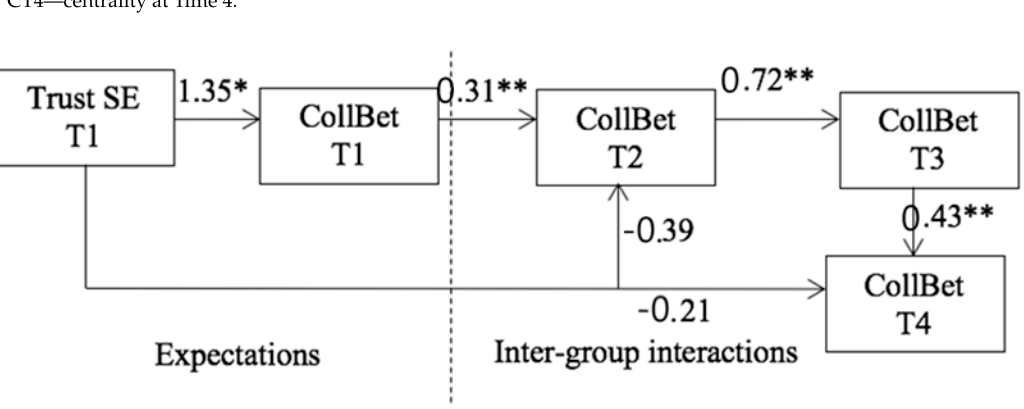
Results of the sequential mediation model for collaboration betweenness. Note: SE—self-enhancement, CollBet—collaboration betweenness, T1 = Time 1, T2 = Time 2, etc., * p < 0.05; ** p < 0.01; path coefficients are non-standardized coefficients reported from the most complete model, i.e., the model in which all previous variables in the mediation chain are